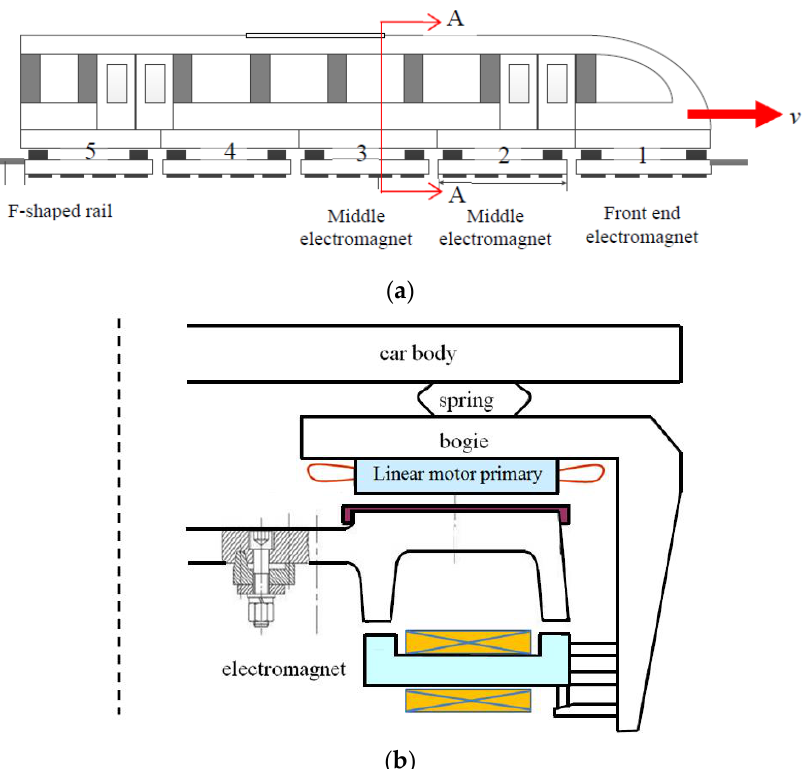
Figure 1. Levitation system diagram of mid-low speed Maglev train: ( a ) The lateral view of five electromagnet modules in one train carriage; ( b ) The cross section of the train (A-A).